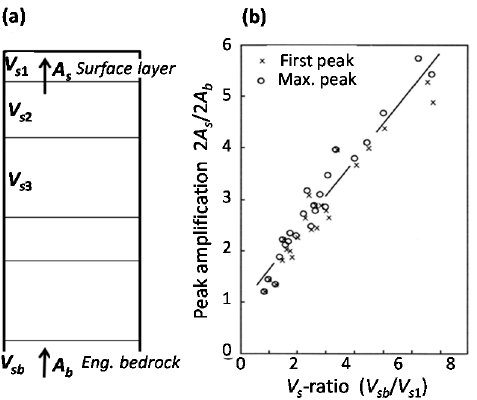
Figure 1. 1D response analysis of horizontally layered soil model ( a ), and peak amplification between base and surface of 2 A s /2 A b versus V s -ratio ( b ) (Shima 1978 [3]).